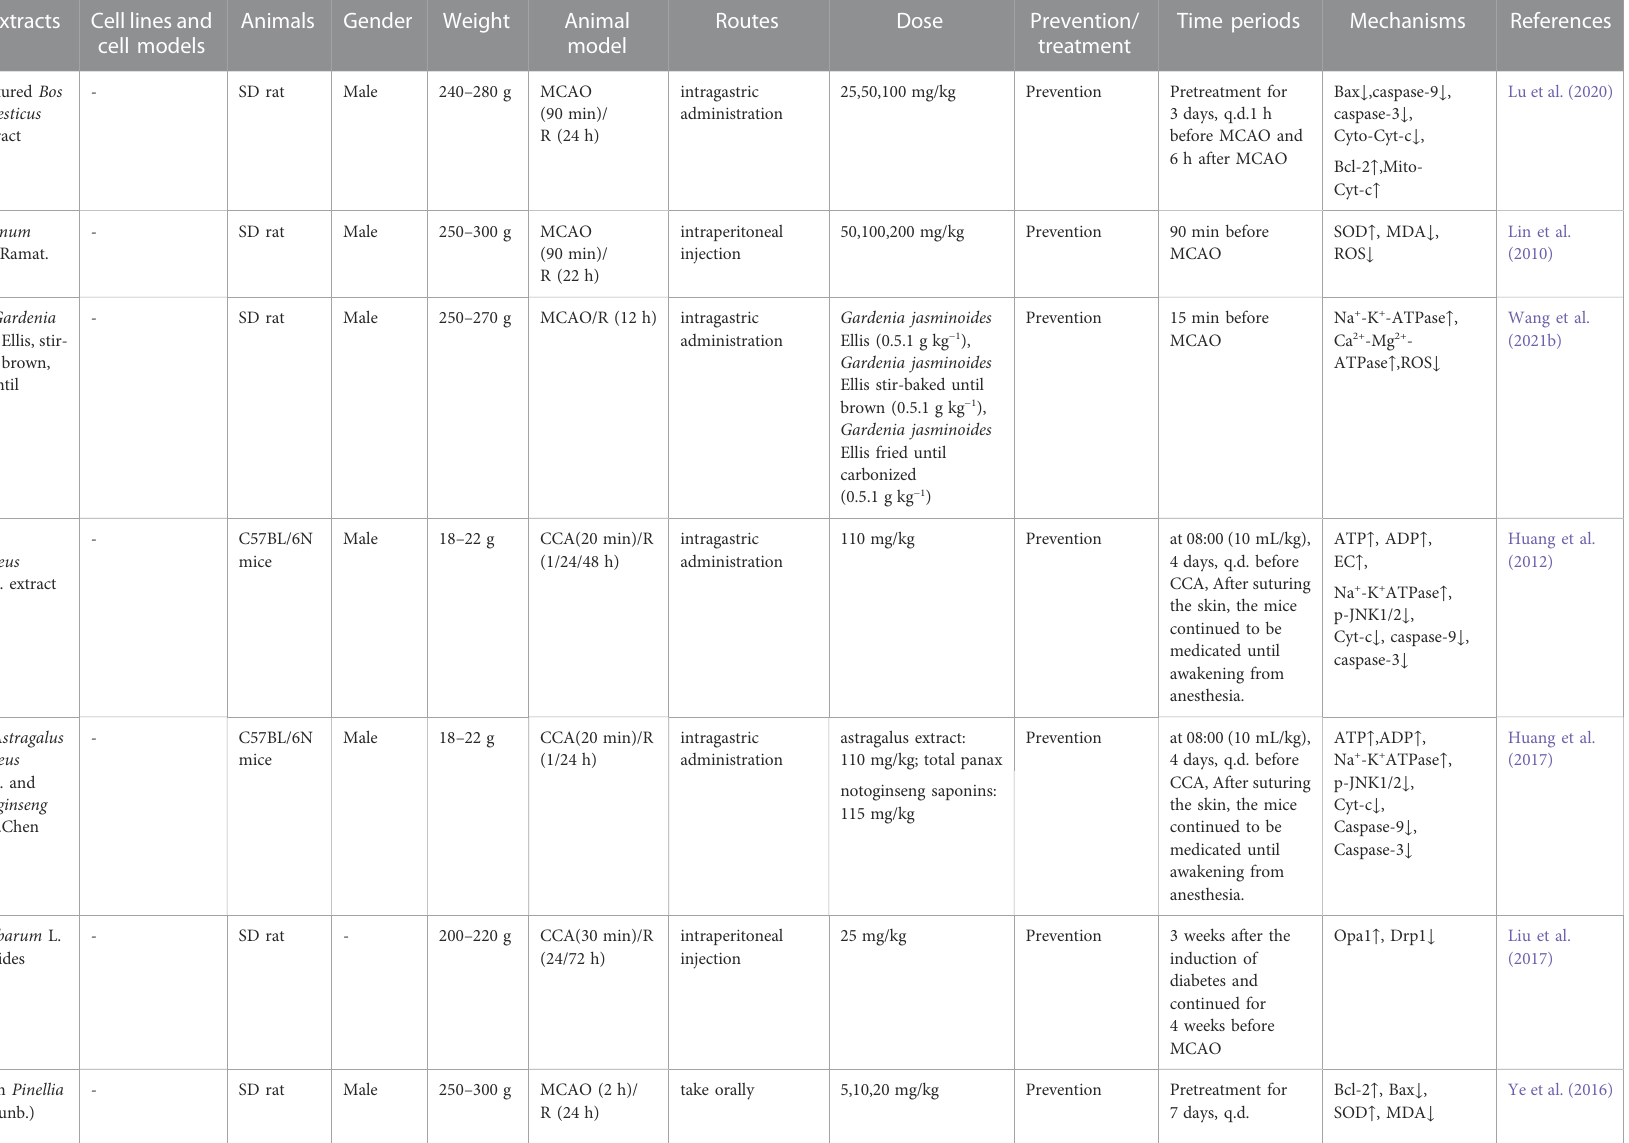
TABLE 2 The molecular mechanism of herbal extracts in the treatment of ischemic stroke by targeting mitochondria. Herbal